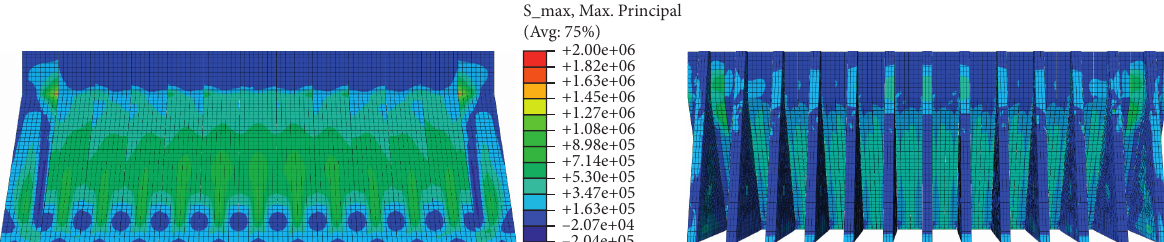
Figure 23: Maximum envelope of maximum principal stresses at upstream and downstream of buttress dam induced by the Taft earthquake considering only stream motion.